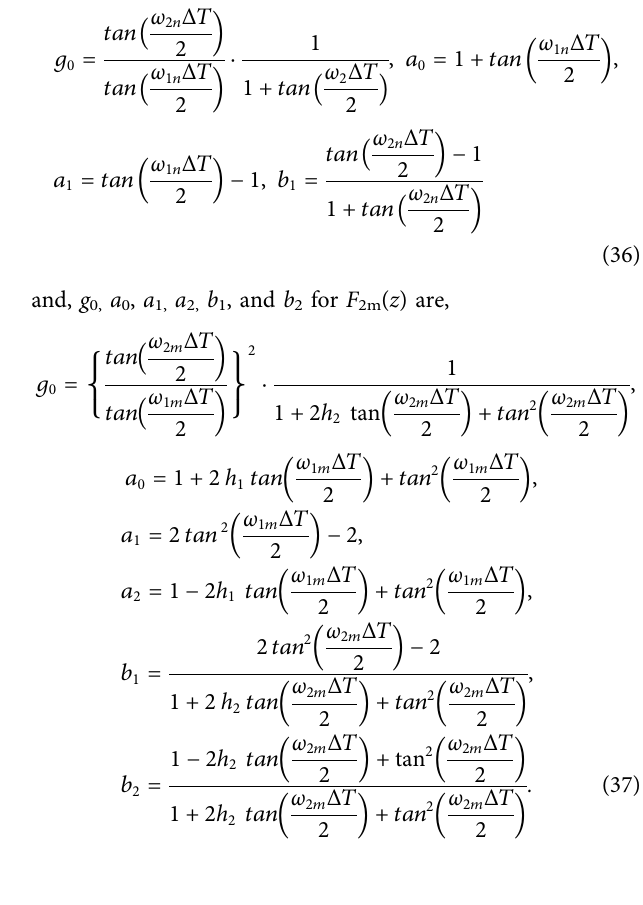
Frontiers in Earth Science |